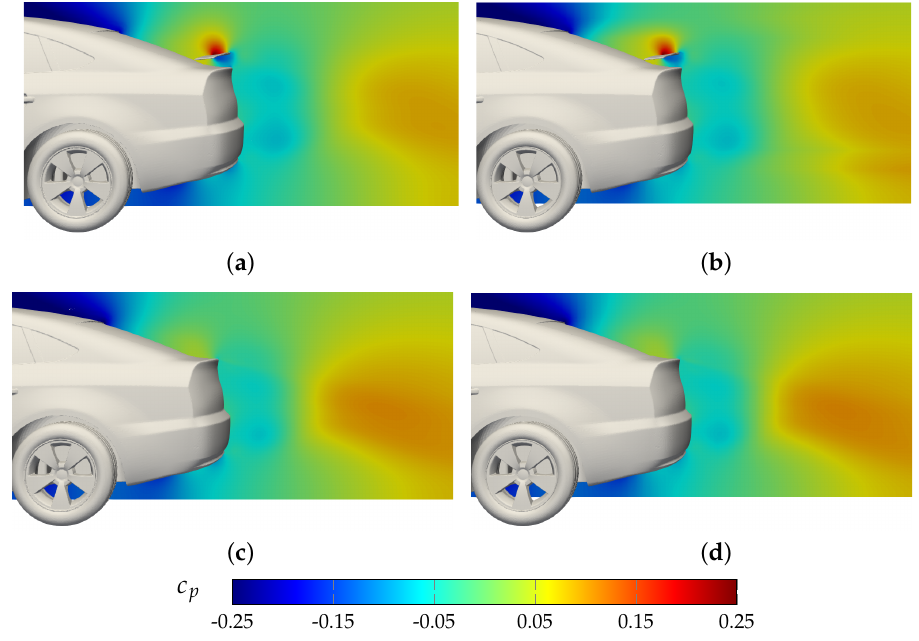
Figure 14. CFD solutions and oPOD predictions for c p at p ∗ with and without spoiler. ( a ) CFD solution for c p with spoiler. ( b ) oPOD prediction for c p with spoiler. ( c ) CFD solution for c p without spoiler. ( d ) oPOD prediction for c p without